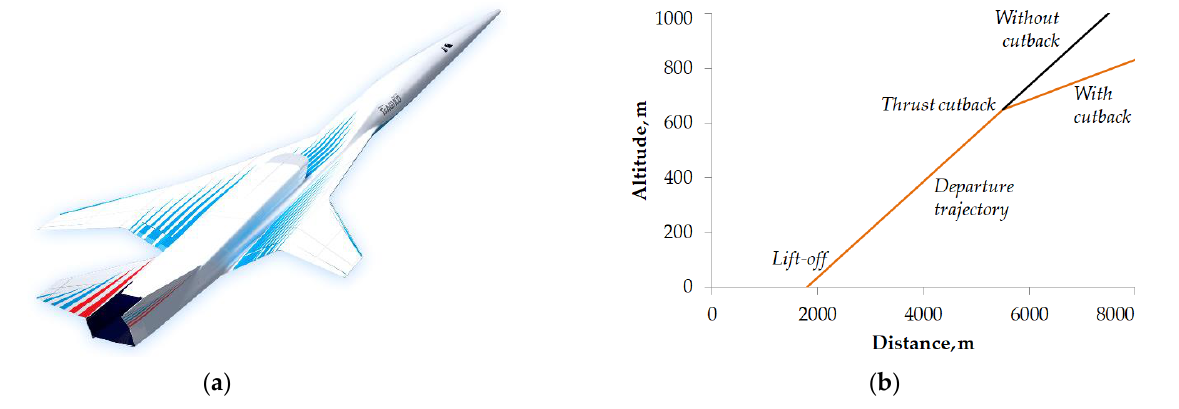
Figure 2. A concept of next-generation supersonic civil aircraft developed by TsAGI: ( a ) a general view of the aircraft; ( b ) departure trajectory for the aircraft.